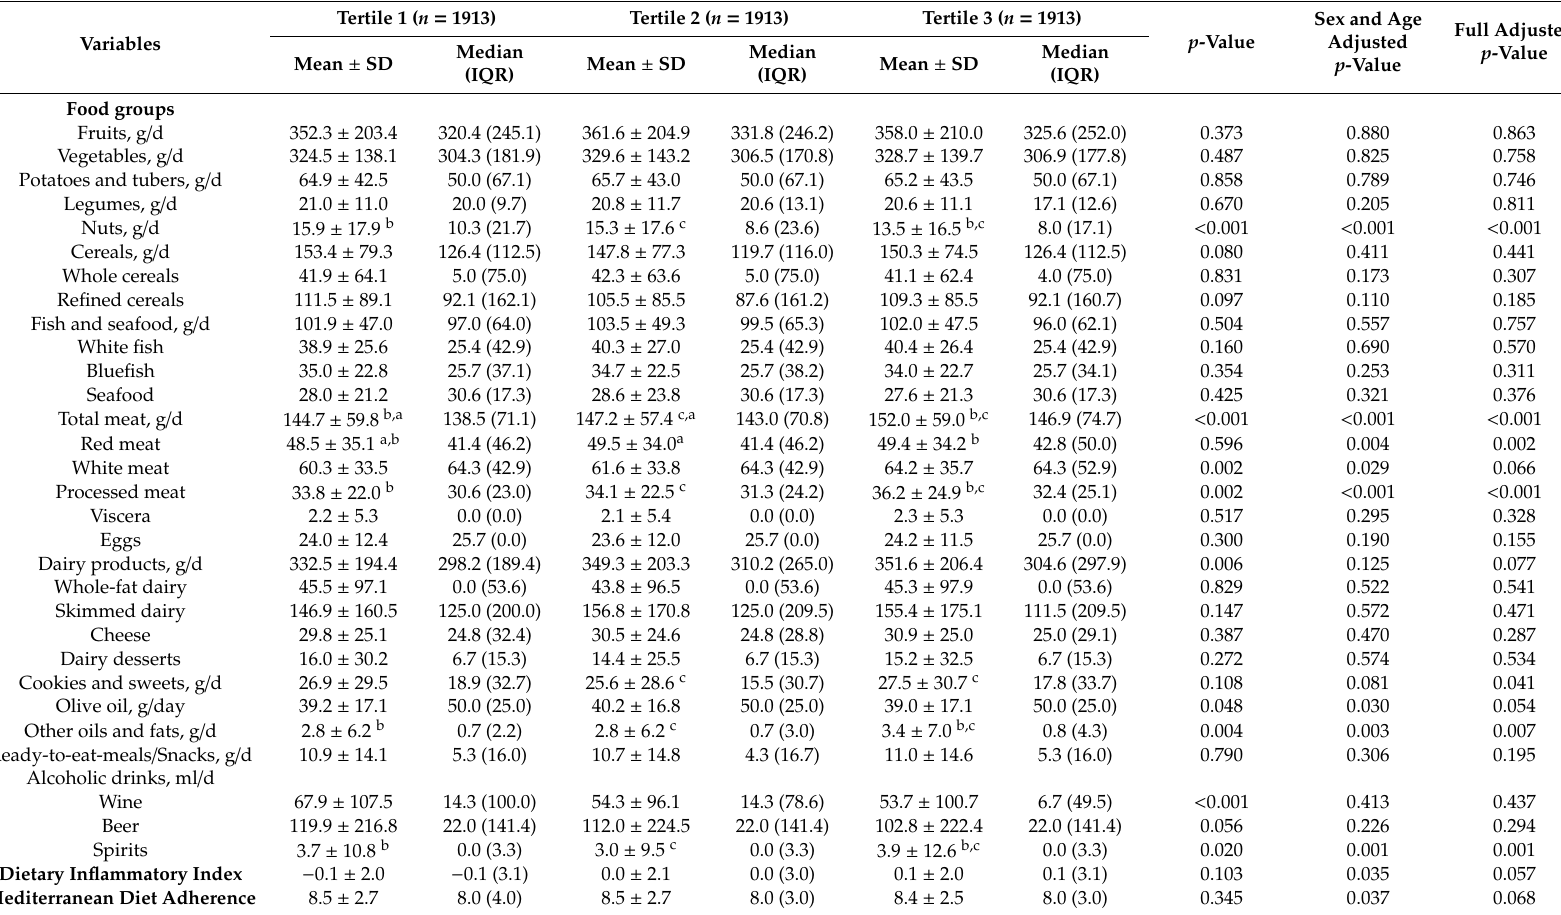
Table 5. Food consumption, Dietary Inflammatory Index, and adherence to Mediterranean Diet according to tertiles of Metabolic Syndrome Severity Score (MetSSS).